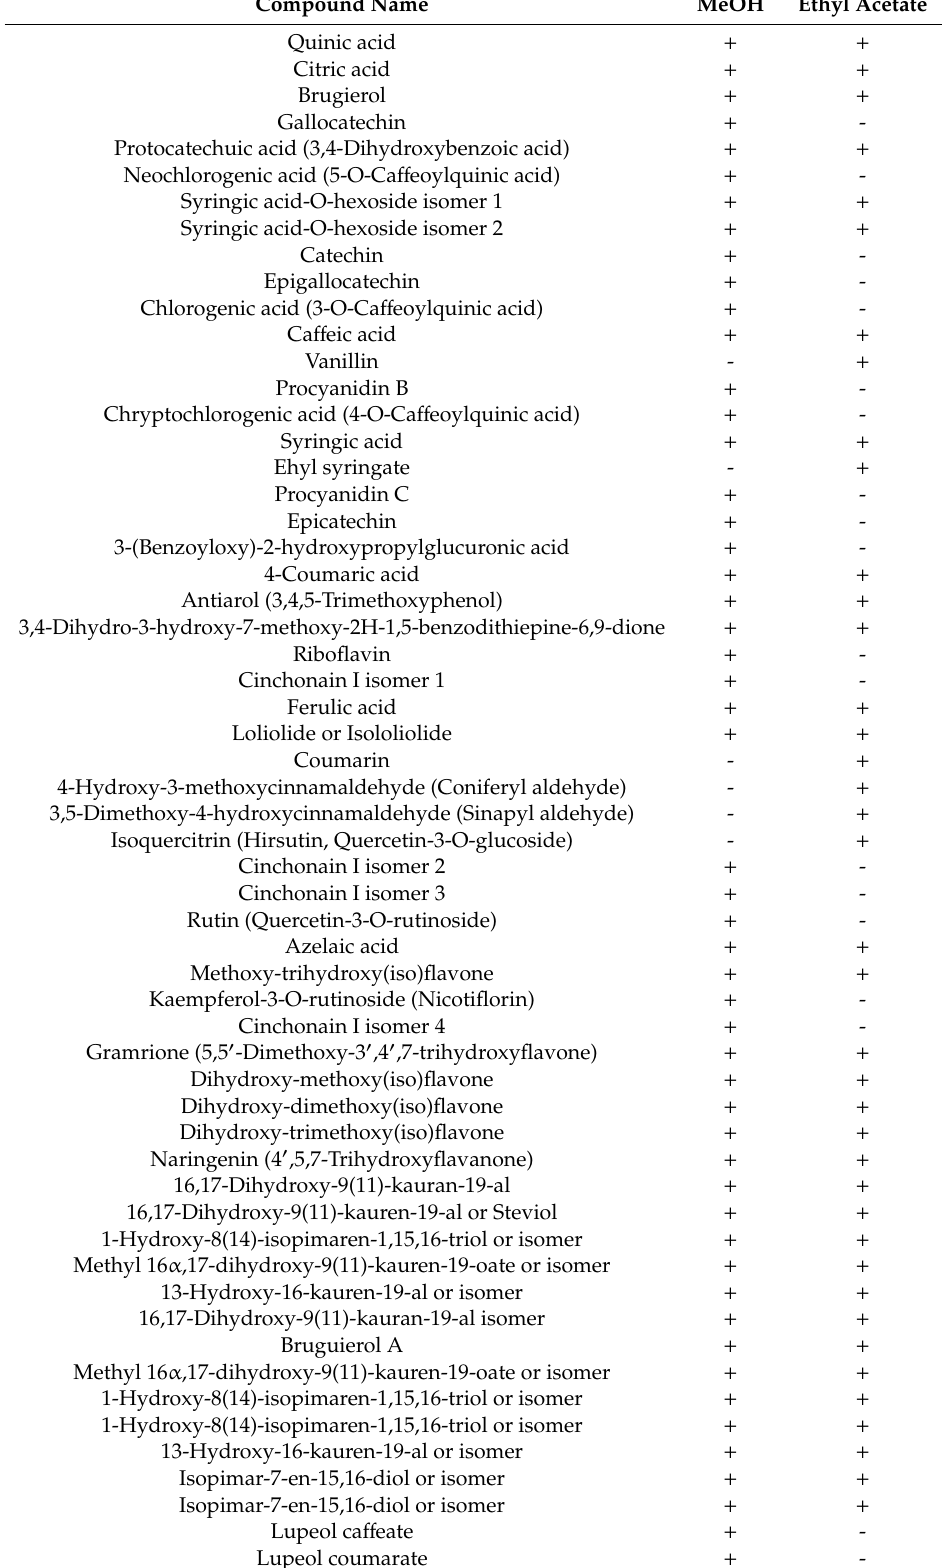
Table 4. Chemical composition of twig